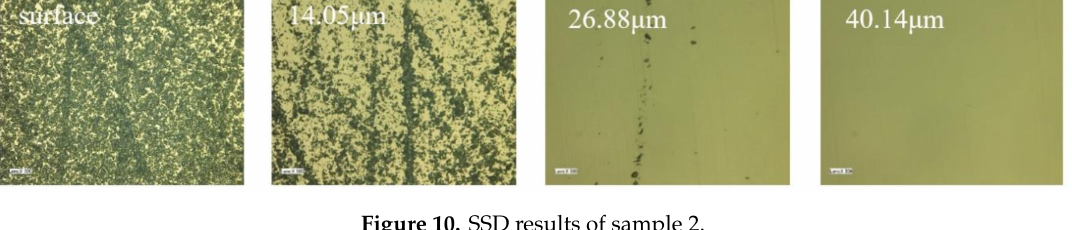
Figure 10. SSD results of sample 2.